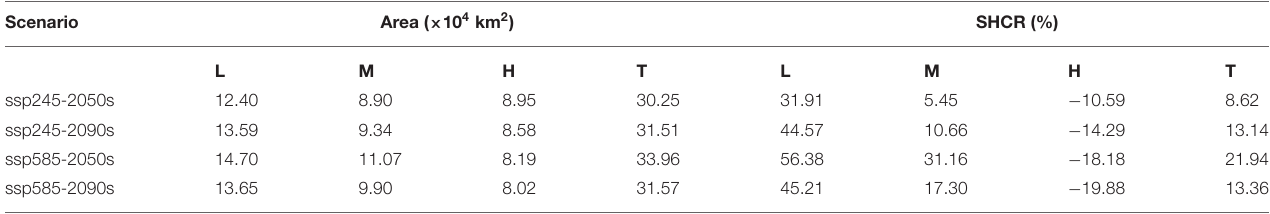
TABLE 2 | The distribution area and suitable habitat change rate of Panax notoginseng under future climate